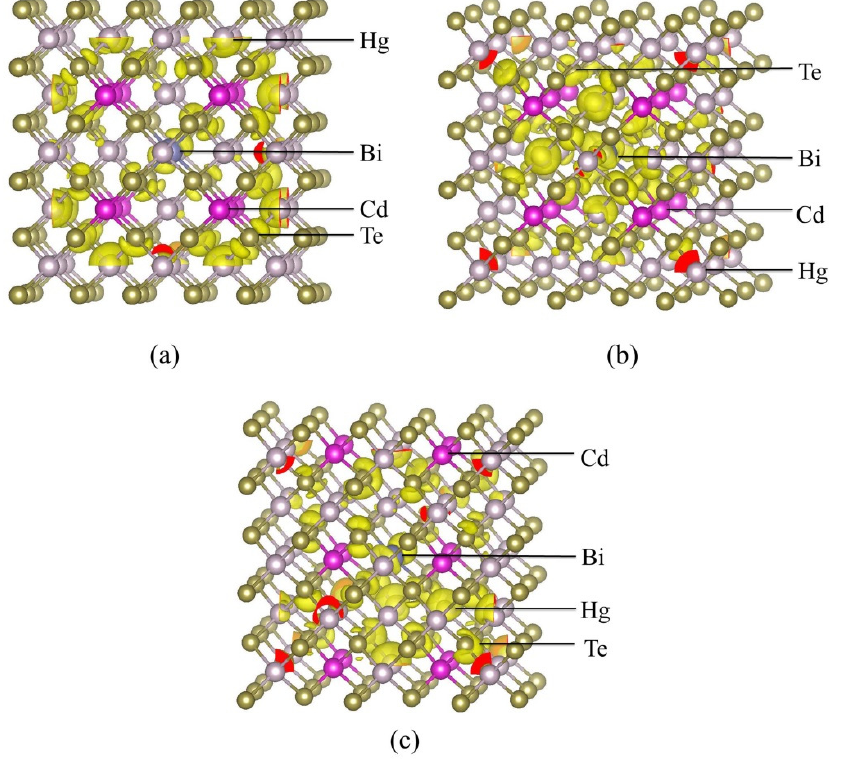
Figure 9. The band decomposed charge density of ( a ) V1, ( b ) V2, ( c ) V3, isosurfaces correspond to 0.006 e/Å.